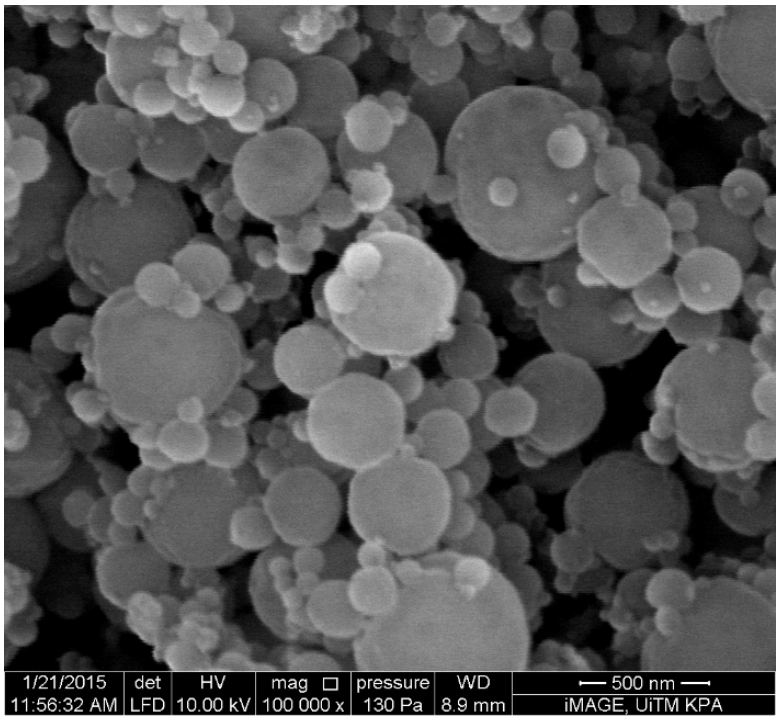
Figure 3. Scanning electron microscopic image of chitosan nanoparticles.